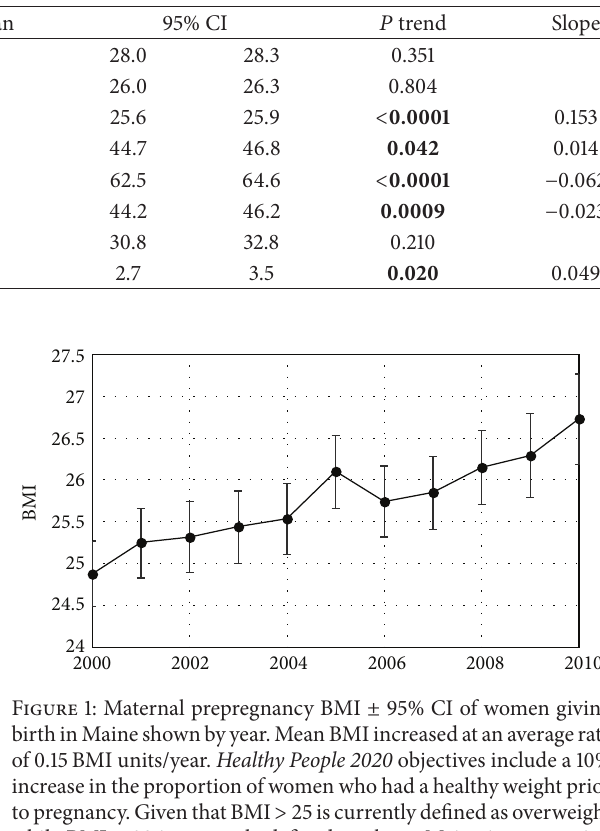
Table 1: Prepregnancy demographics for women giving birth in Maine, 2000–2010.